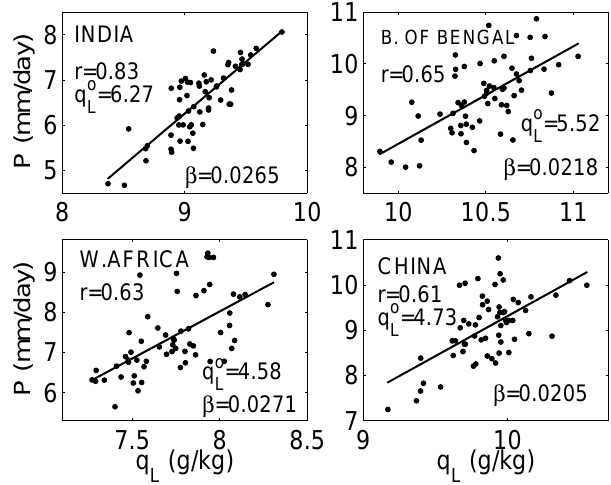
Fig. 3. Wind U versus temperature difference between land and ocean region, 1T , from NCEP/NCAR reanalysis data, for the ma- jor monsoon regions of India, the Bay of Bengal, West Africa, and China (East Asia; see Table 1). The correlation coefficient r is indi- cated, as well as the slope α of a linear fit through the origin (black line).